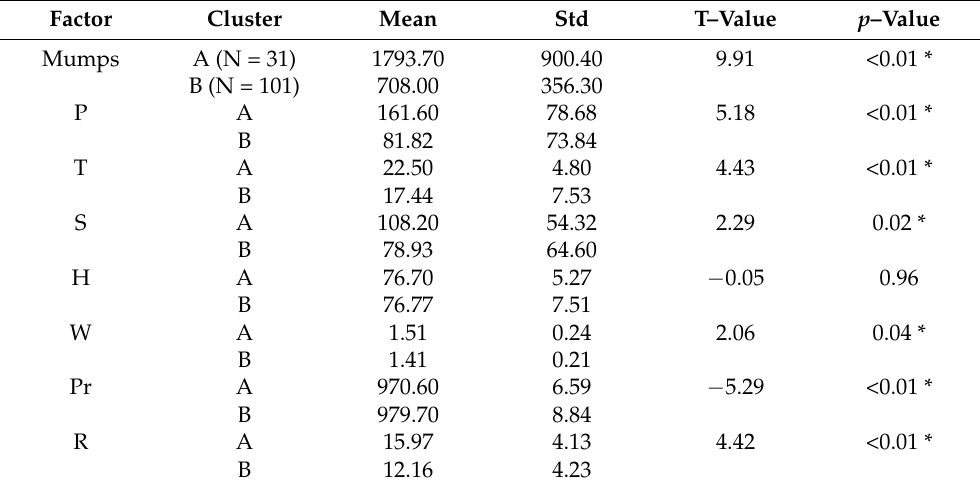
Table 1. t –test of meteorological factors and mumps cases in Chongqing, 2009–2019.